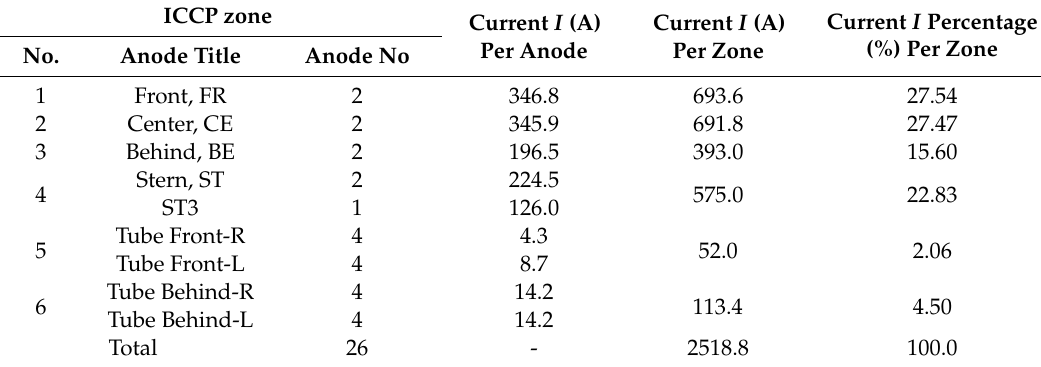
Table 1. Current I (A) supplied by the proposed ICCP system configuration.